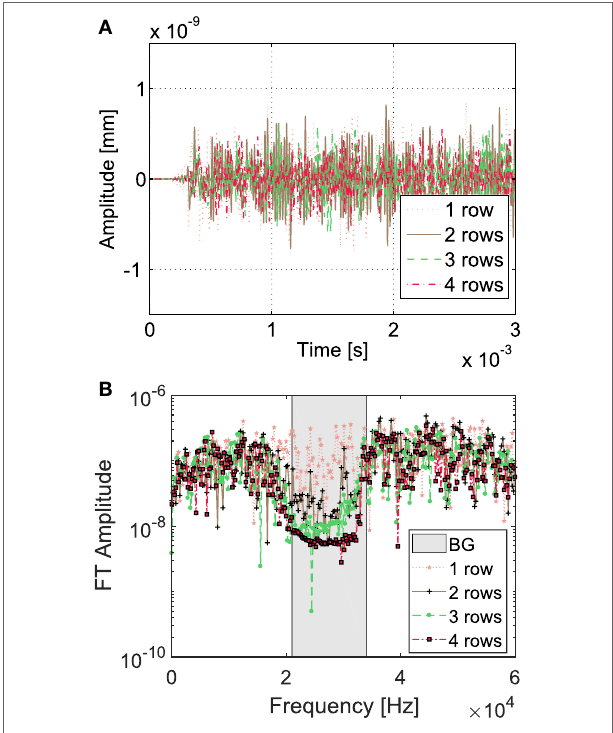
FigUre 7 | (a) Out-of-plane displacement for the phononic plate with 1, 2, 3, and 4 rows and (B) its Fourier Transform (FT) amplitude. The gray region denotes the calculated BG.